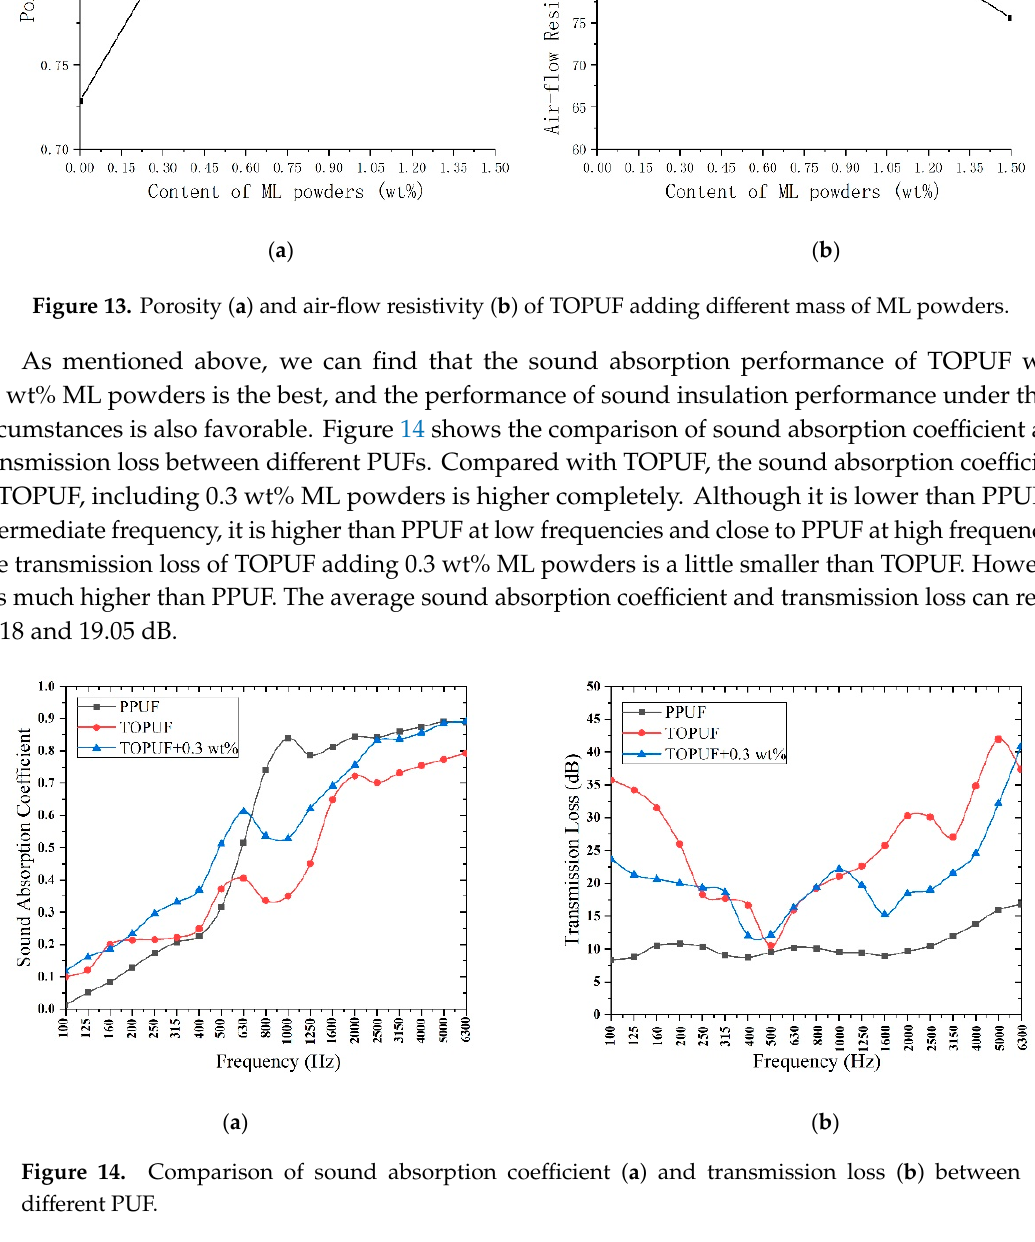
ff erent mass of ML powders.